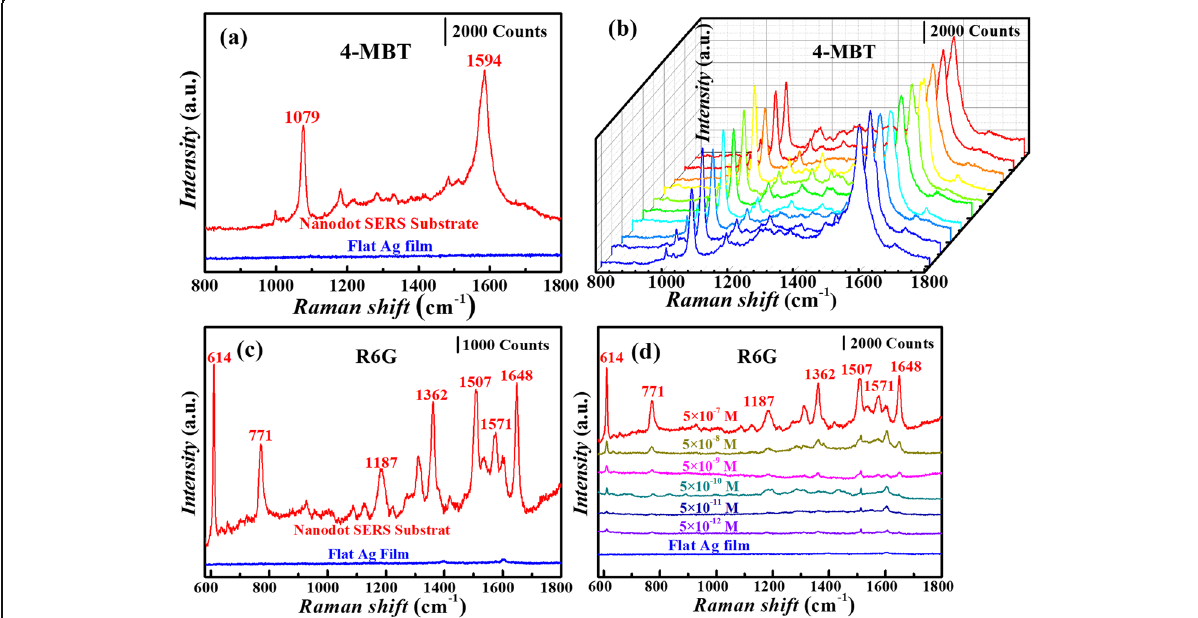
Fig. 4 a Raman spectra of 10 -4 M 4-MBT on a SERS substrate with NDs prepared under the optimized conditions. b 10 Raman spectra of 10 -4 M